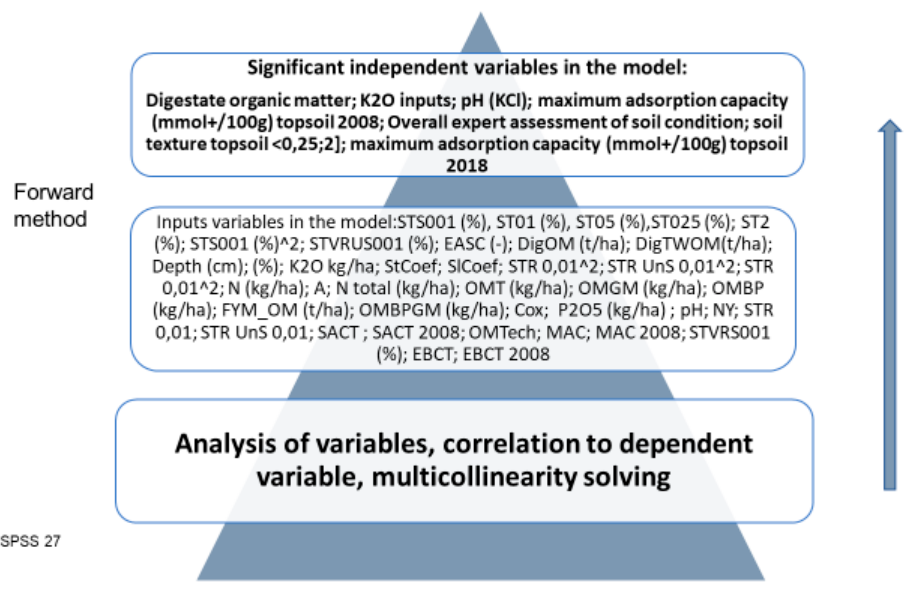
Figure 6. Model 2: Difference of HWEC content (2008–2018).